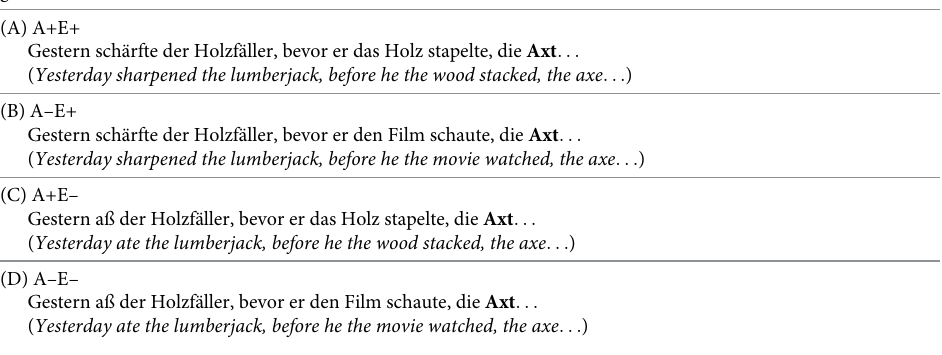
Table 1. Design. Example item crossing the factors expectancy (E+–) and lexical association (A+–). Literal translation given in